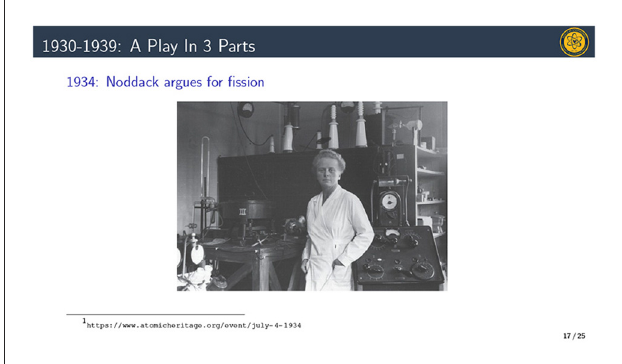
FIGURE7 Important players in twentieth-century physics—Noddack. Lecture W4L7.